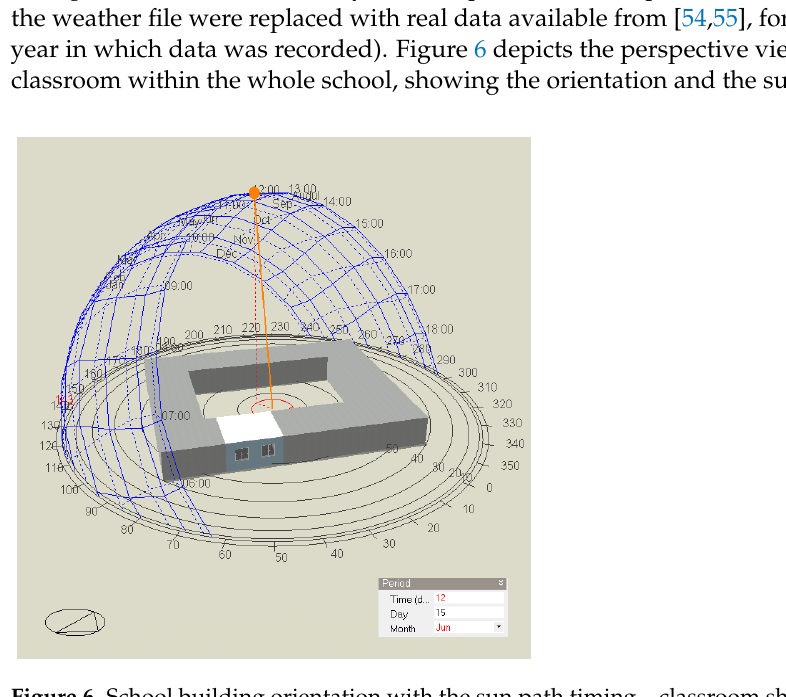
Figure 5. ( a ) Benetch anemometer for recording indoor classroom air speed and ( b ) temperature measurement with Hobo loggers.